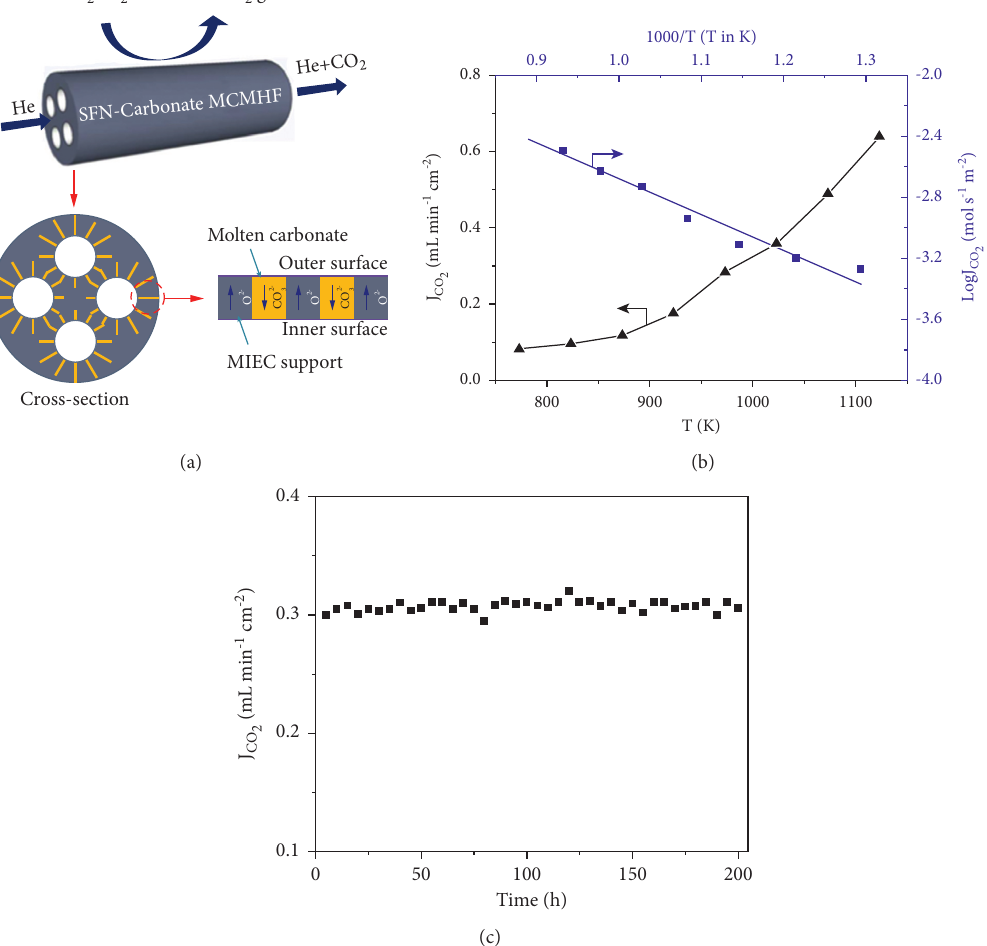
Figure 12: (a) Structure of multichannel hollow fibre SNF membrane. (b) Effect of temperature on CO 2 permeation flux of SFN-MC membrane. (c) Stability test: CO 2 permeation flux as a function of time [45]. Table 5: Comparison of CO 2 fluxes for MC membranes with different